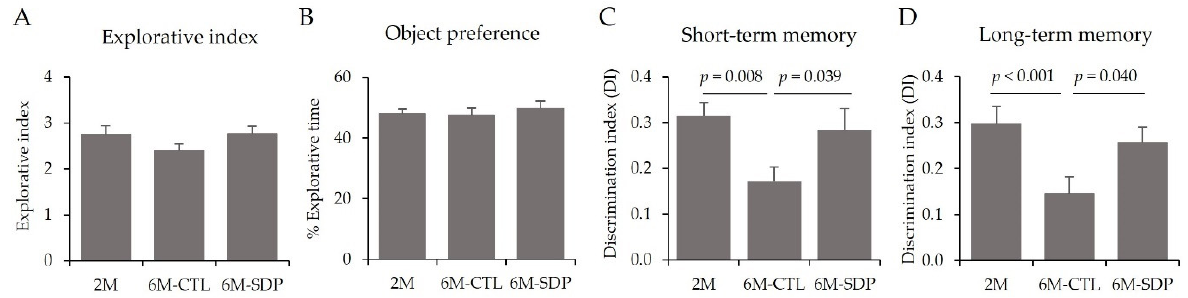
Figure 3. Novel object recognition test (NORT). Explorative index ( A ), object preference ( B ), short- term memory ( C ), long-term memory ( D ). Results are expressed as mean ± SEM ( n = 11–12 mice/group). Statistics: ANOVA (Fisher multiple comparison